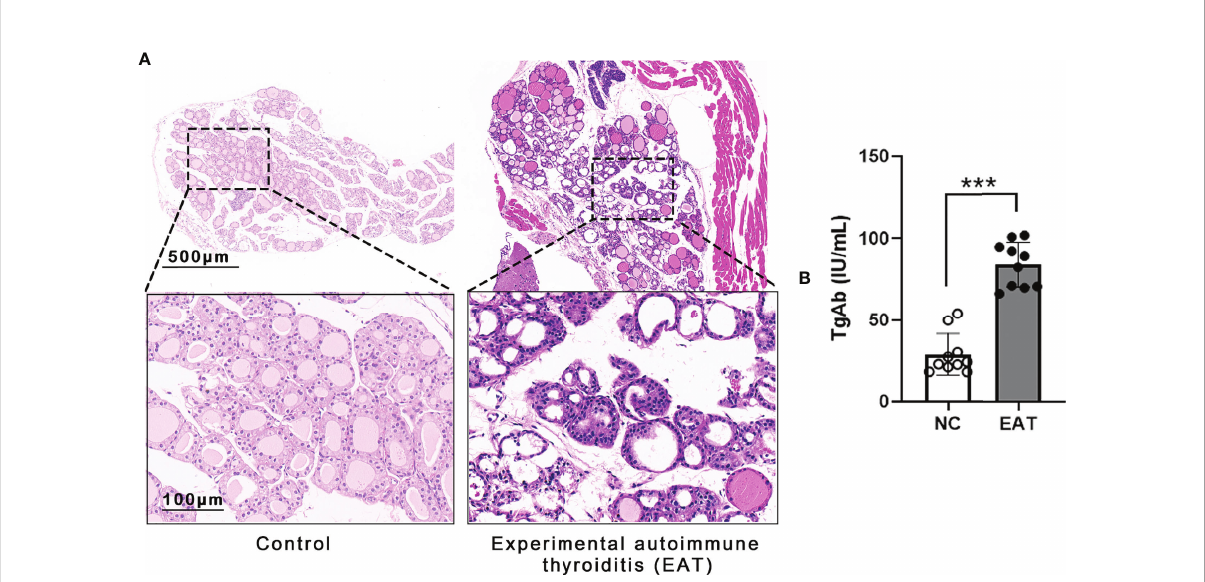
FIGURE 2 Experimental autoimmune thyroiditis (EAT) in mice. (A) The EAT mouse model was replicated by ingestion of 0.05% sodium iodine water. The thyroid follicular epithelial cells were necrotic, and a large number of lymphocytes in fi ltrated the thyroid gland of EAT group. (B) Compared with the NC group, the serum level of thyroid autoantibody TgAb was signi fi cantly increased in the EAT group. The above features indicate that the EAT model was successfully replicated. *** P <